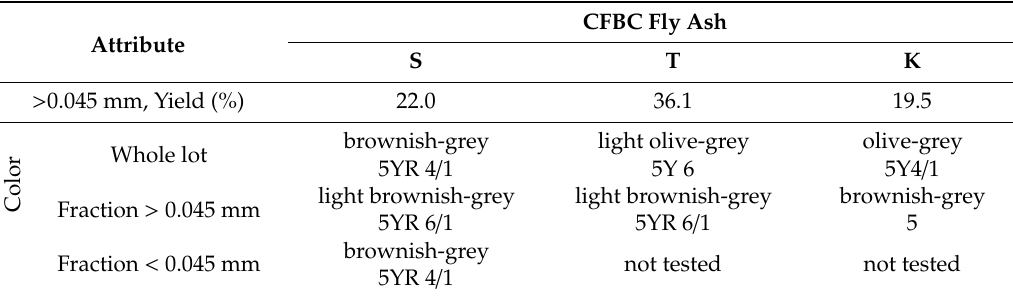
Table 4. Result of macroscopic analysis of the CFBC ashes: S, T and K. CFBC Fly Ash Attribute S T K